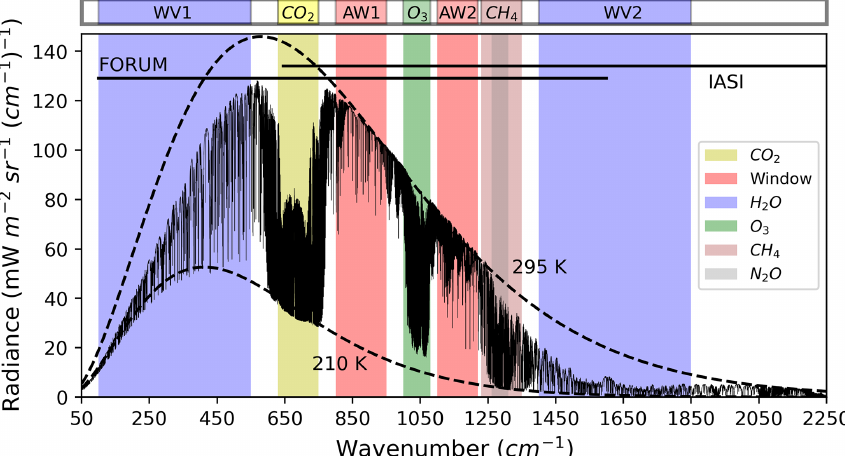
Figure 1. Spectrum simulated in clear-sky conditions over tropical ocean by the σ -IASI RTM. The main absorption bands are highlighted. Dashed lines show the equivalent blackbody emission at typical surface (295K) and tropopause (210K) temperatures.